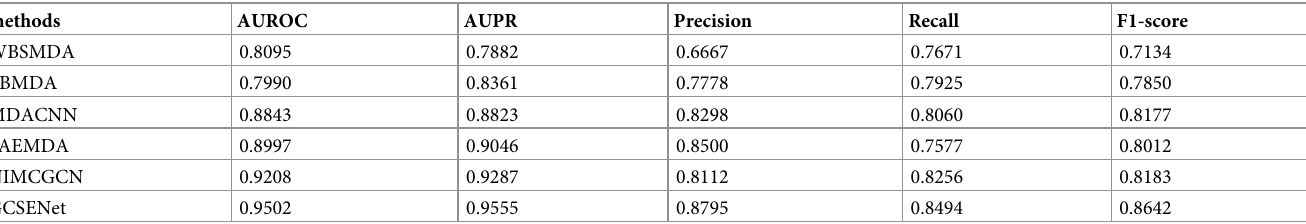
Table 2. Performance comparison with typical methods for miRNA-disease association